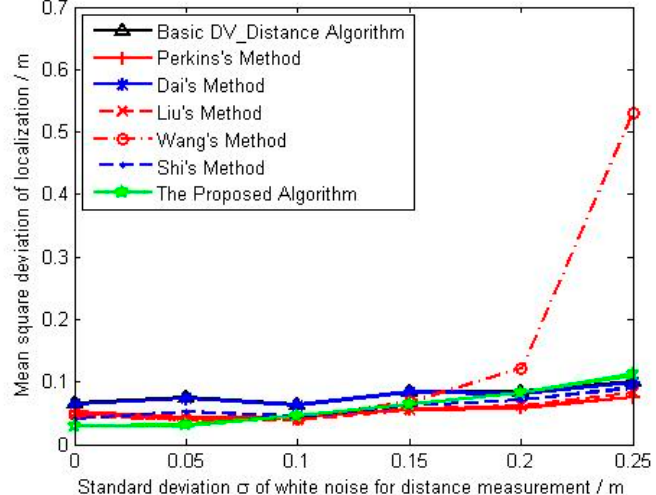
Figure 6. The change curve of mean square deviation with noise intensity.